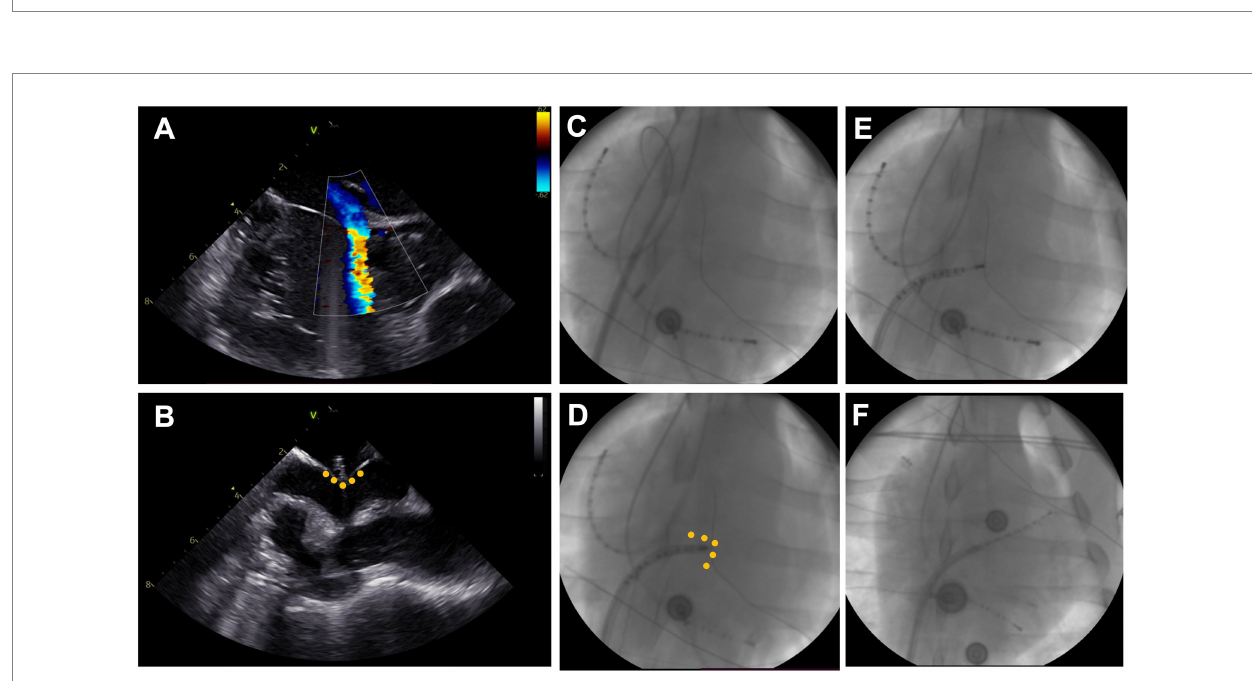
FIGURE 2 Transseptal puncture. (A) Visualization of a patent foramen ovale with right-to-left shunt on intracardiac echocardiography (ICE). (B) ICE-Visualization of blunt transseptal puncture through fossa ovalis showing tenting (yellow dots) and narrow left atrium. (C) Fluoroscopy image in anterior–posterior projection with decapolar catheter in high right atrium (left top) and coronary sinus (bottom right). The steerable sheath is advanced into the superior vena cava over the wire. (D) The sheath is retracted to the fossa ovalis and a diagnostic catheter is advanced. (E) Blunt passage of the fossa ovalis using the diagnostic catheter. (F) Positioning of the diagnostic catheter in the left atrial appendage and advancement of the steerable sheath into the left